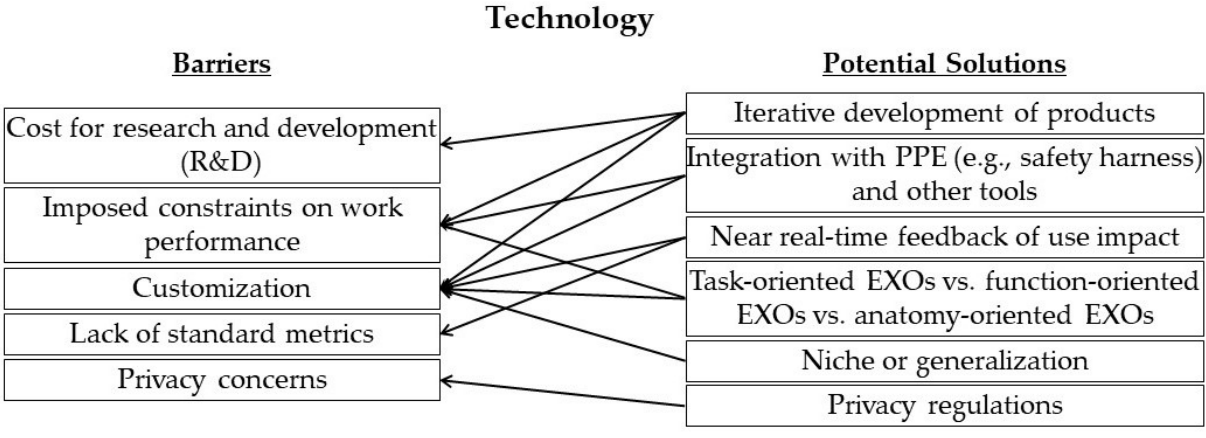
Table 5. Summary of organization category